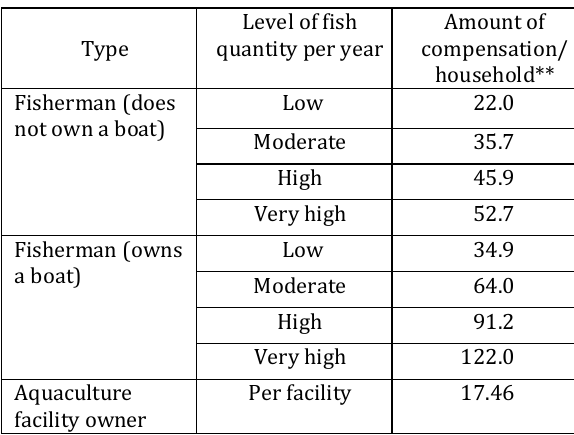
Table 4. Amount of financial compensation for four affected provinces in Central region: Ha Tinh, Quang Binh, Quang